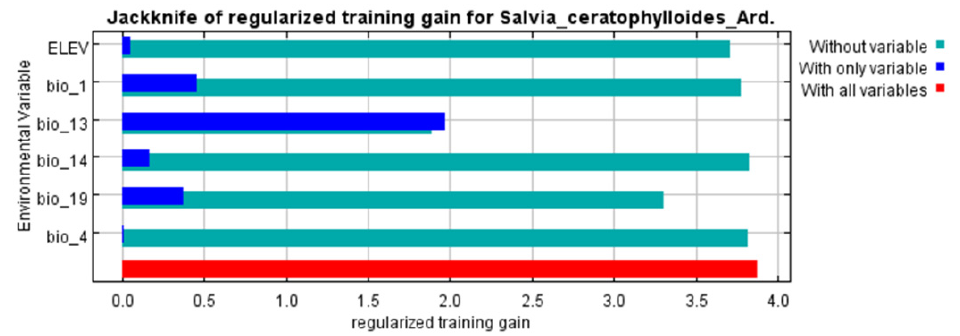
della Cattina, Aretina; 19—Lutr à , Fiumara di Sant’Agata; 20—Galluzzi, Gallico Superiore; 21—Pietra Storta; 22—Croce Missionaria, Terreti; 23—Fontana Acqua Fresca, Straorino. In the top left-hand corner, the distribution area of the points of occurrence is highlighted in red.